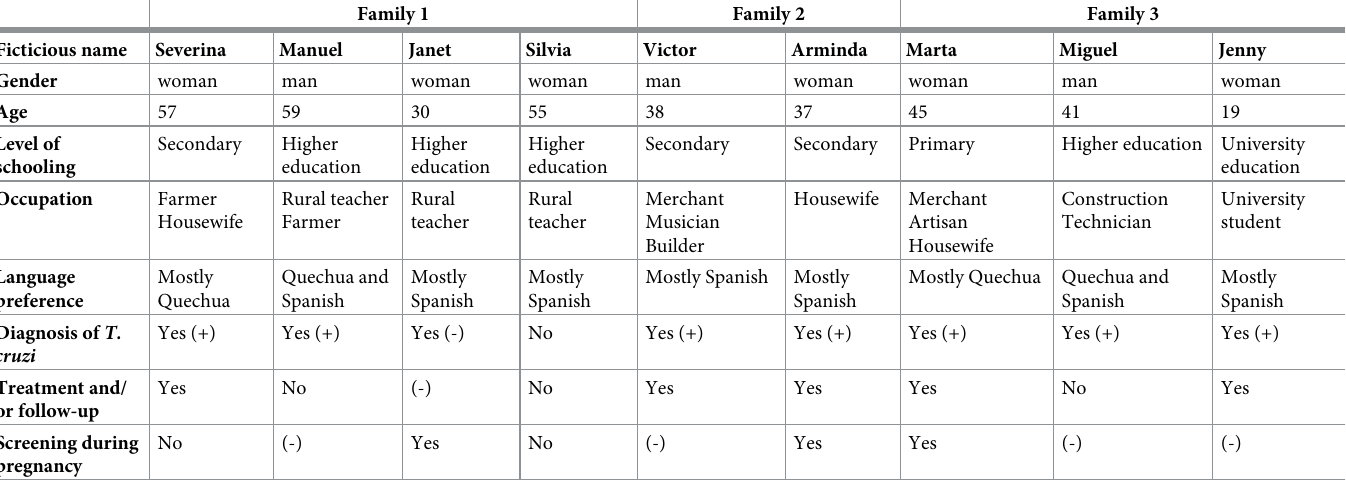
Table 2. Subjects in the study grouped by families and their main general characteristics.